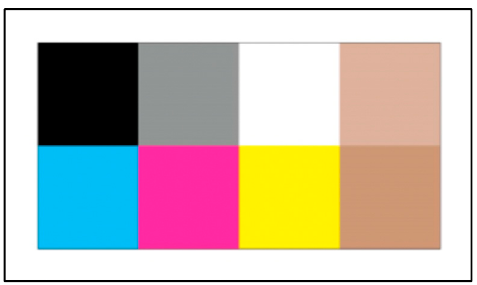
Figure 2. Color calibration card.